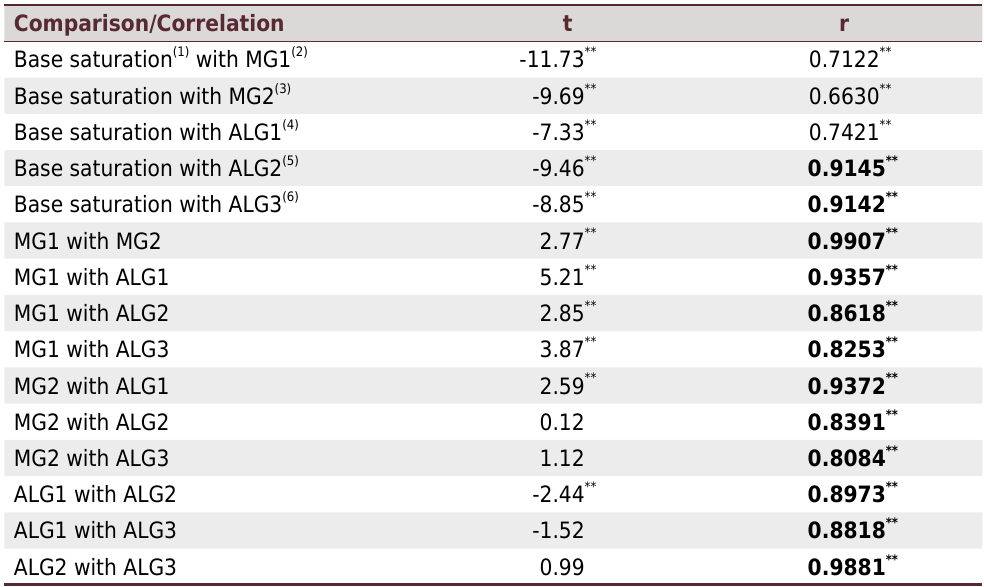
plantings, in regard to crop requirements and tolerance (V = 60 %, X = 3.5 and m t = 25 %) Comparison/Correlation